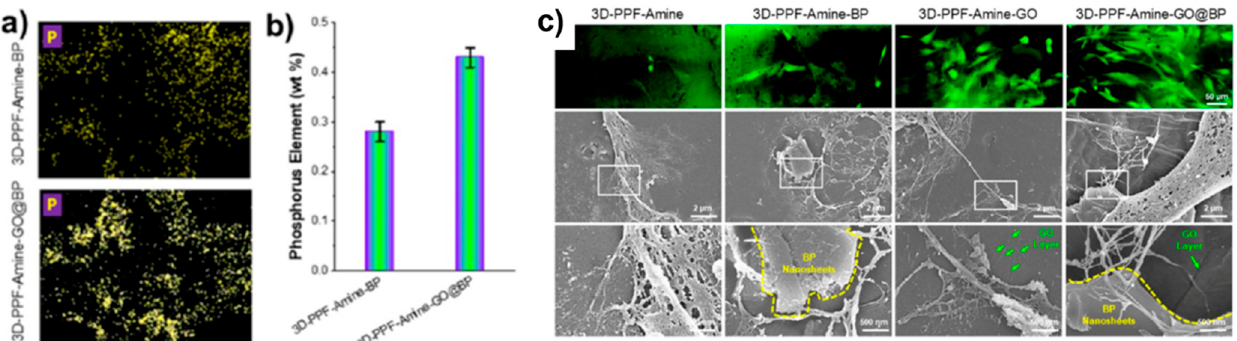
Figure 8. ( a ) Phosphorous elemental mapping on 3D scaffolds functionalized with BP and GO@BP nanosheets and ( b ) calculated amount of phosphorus content. ( c ) Immunofluorescence and SEM images showing the morphology of MC3T3 pre-osteoblast cells after 1 day of growth on functionalized 3D scaffolds (yellow lines indicate the edges of BP nanosheets; green arrows point to GO layers). Adapted with permission from ref. [118]. Copyright 2019 American Chemical Society.